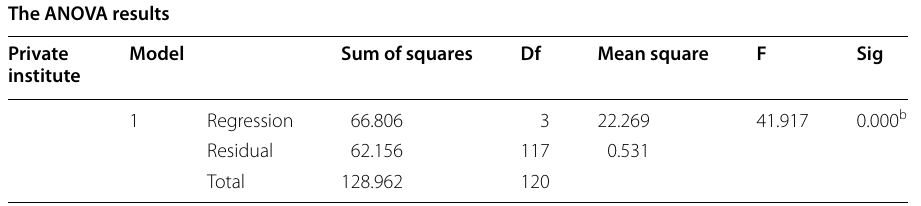
Table 13 The ANOVA a results for private institute learners